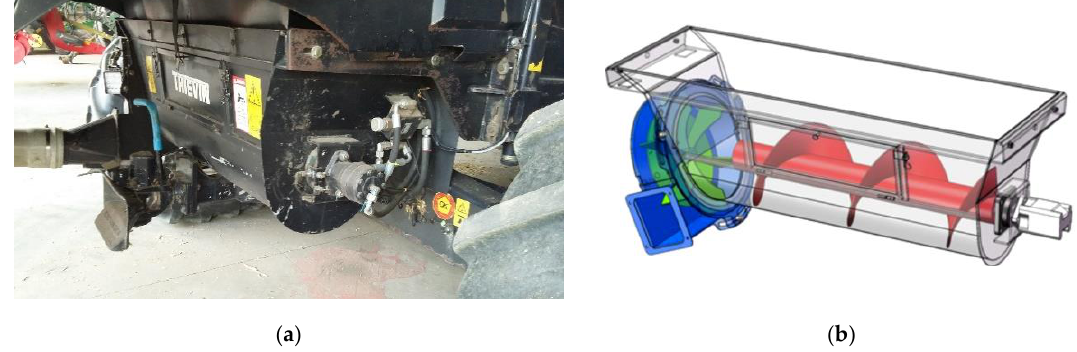
Figure 2. ( a ) Thievin system “Turbopaille” for chaff collection and ( b ) schematic representation.